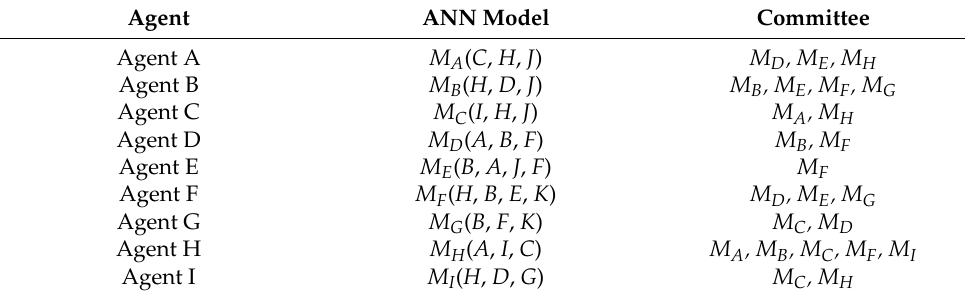
Table 6. Agents, estimated signals, and ANN